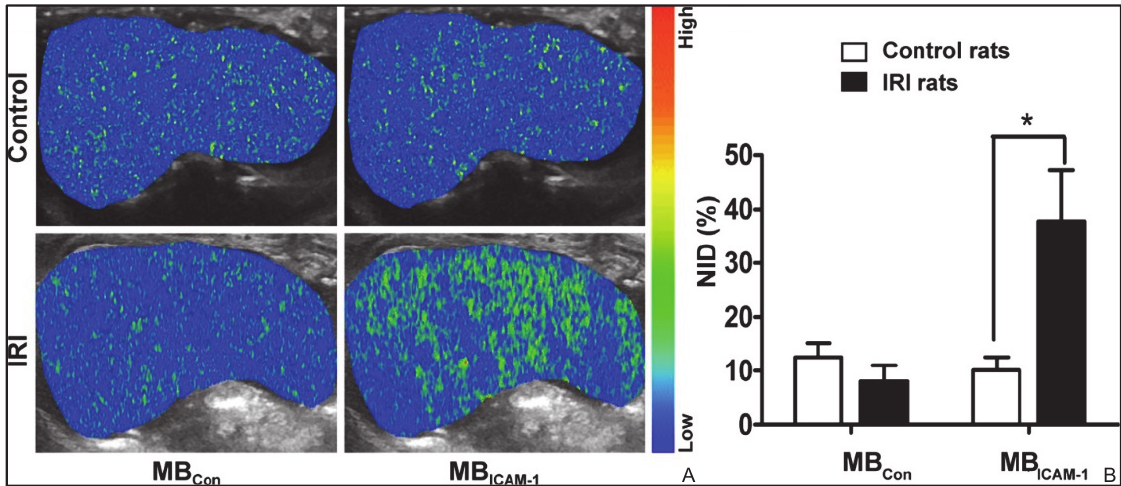
Figure 12 Representative targeted ultrasound (US) images for intracellular adhension molecule-1 (ICAM-1) and normalized intensity difference (NID) in each group. (A) Representative targeted ultrasound (US) images of ICAM-1–targeted microbubbles (MBICAM-1) and control microbubbles (MBCON) in ischemia–reperfusion injury (IRI) rats and control rats. US signal after MBICAM-1 in IRI liver was substantially higher than that in control liver and was significantly higher compared with MBCON in IRI liver and normal liver; (B) The normalized intensity differences (NIDs) were calculated as the ratio of subtraction using the destruction–replenishment method ( n = 3, * P = 0.048, IRI group compared with control group after MBICAM-1 administration). (Reprinted with permission from reference [66])